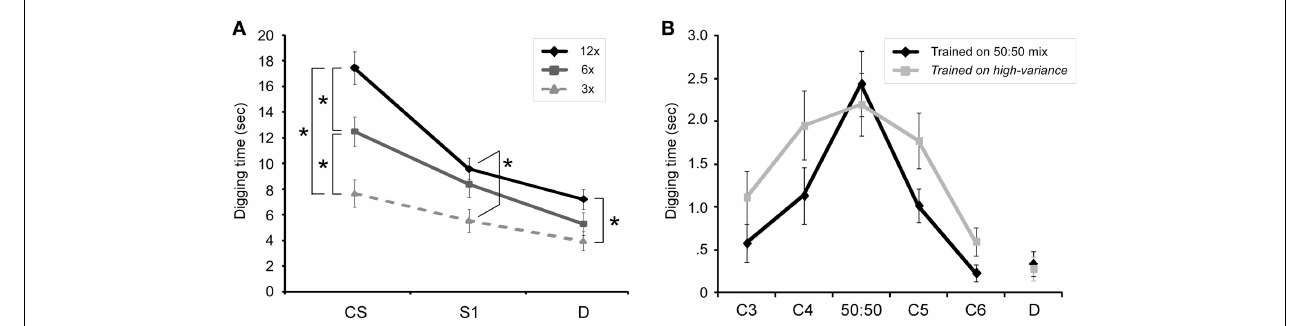
FIGURE 2 | Olfactory generalization gradients in mice. (A) Mice received either 3, 6, or 12 pairings of an odor CS with buried reward, after which their perseverance in digging following randomized presentation of the odor CS, a similar odorant (S1) and a dissimilar odorant (D) was measured. Increasing the number of training trials prior to testing progressively increased perseverance and sharpened associative generalization gradients. 3x: three training trials; 6x: six training trials; 12x: 12 training trials. Asterisks denote significant pairwise differences. Figure adapted from Cleland et al. (2009). (B) Generalization